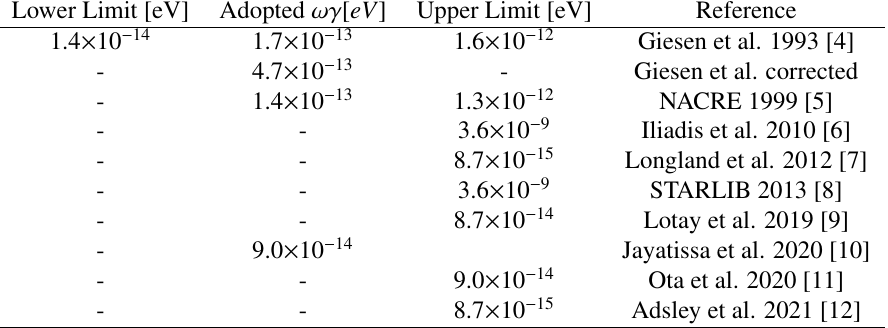
Table 1: Summary of the literature on the E α = 395 keV resonance